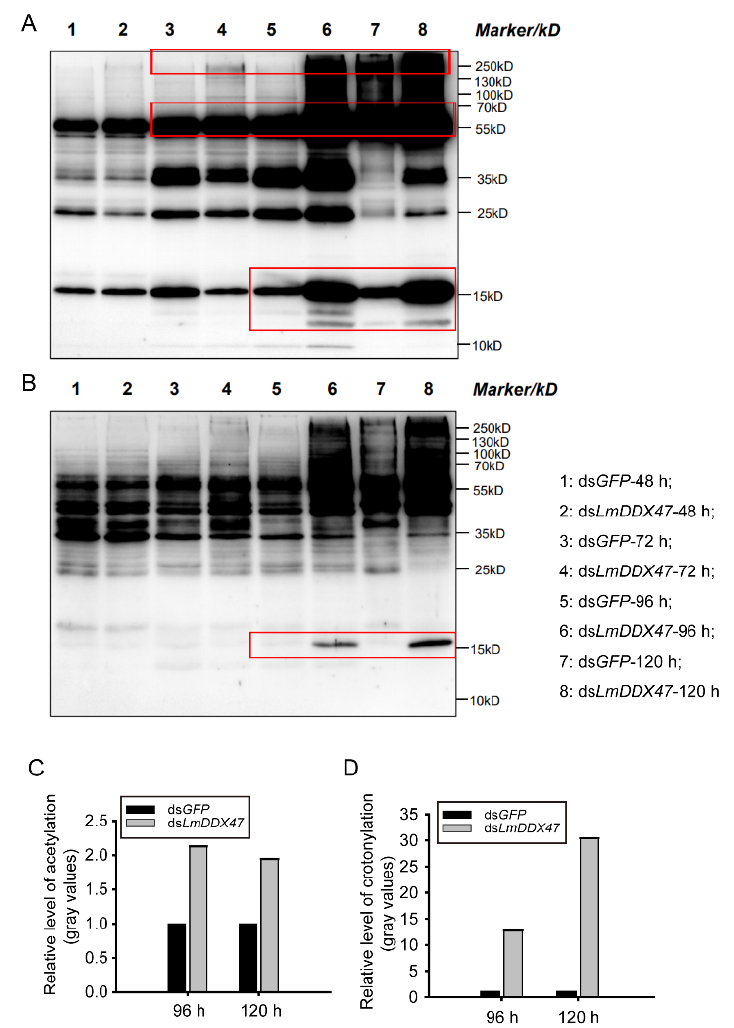
Figure 9. Effects of LmDDX47 on protein modifications in the locust midgut. ( A , B ) Acetylation ( A ) and crotonylation ( B ) levels of midgut proteins were estimated using Western blotting at 48, 72, 96, and 120 h after LmDDX47 RNAi. The red box indicates that the modification of the sample proteins had significantly increased in the LmDDX47 RNAi group. ( C , D ) Relative gray values of acetylation ( C ) and crotonylation ( D ) levels in the 15 kD protein in the ds LmDDX47 -treated group compared with the ds GFP -treated group.